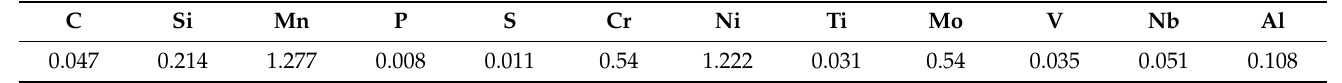
Table 1. Chemical composition of the steel sample